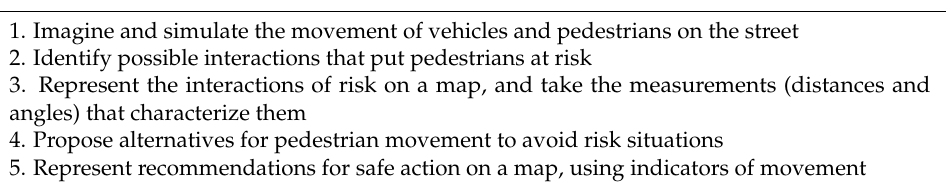
Table 2. Description of the modeling process used to generate recommendations for safe travel in terms of identified